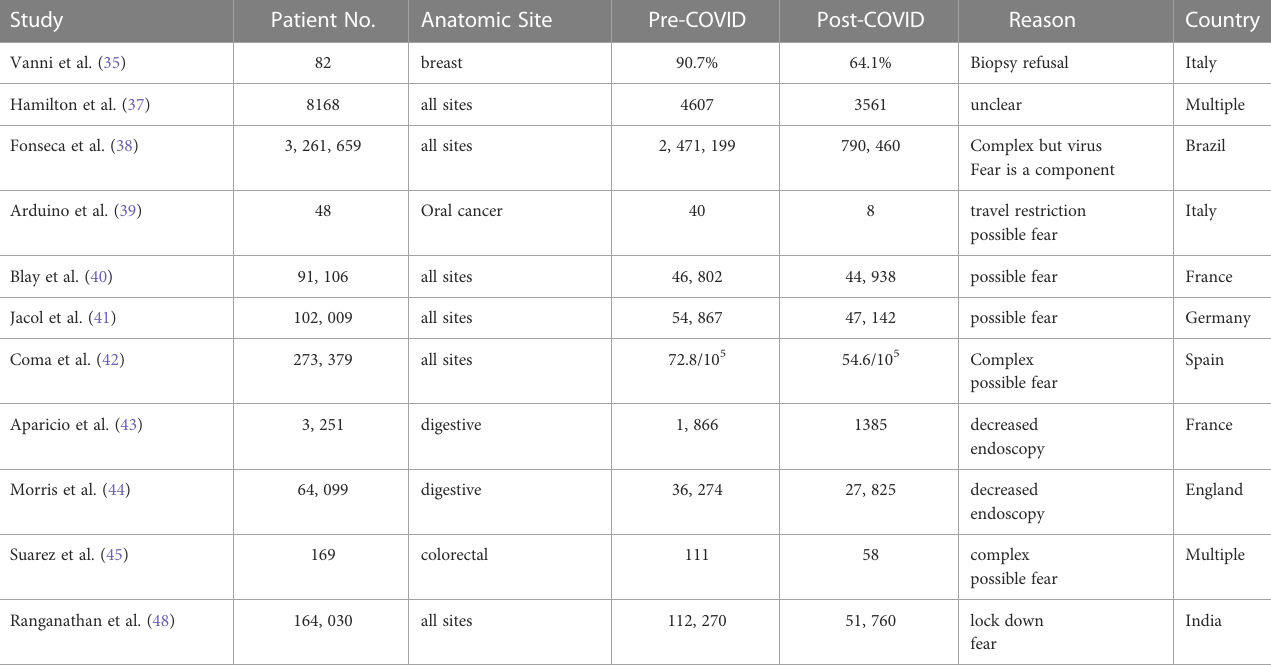
TABLE 1 Decrease in cancer diagnosis during COVID-19